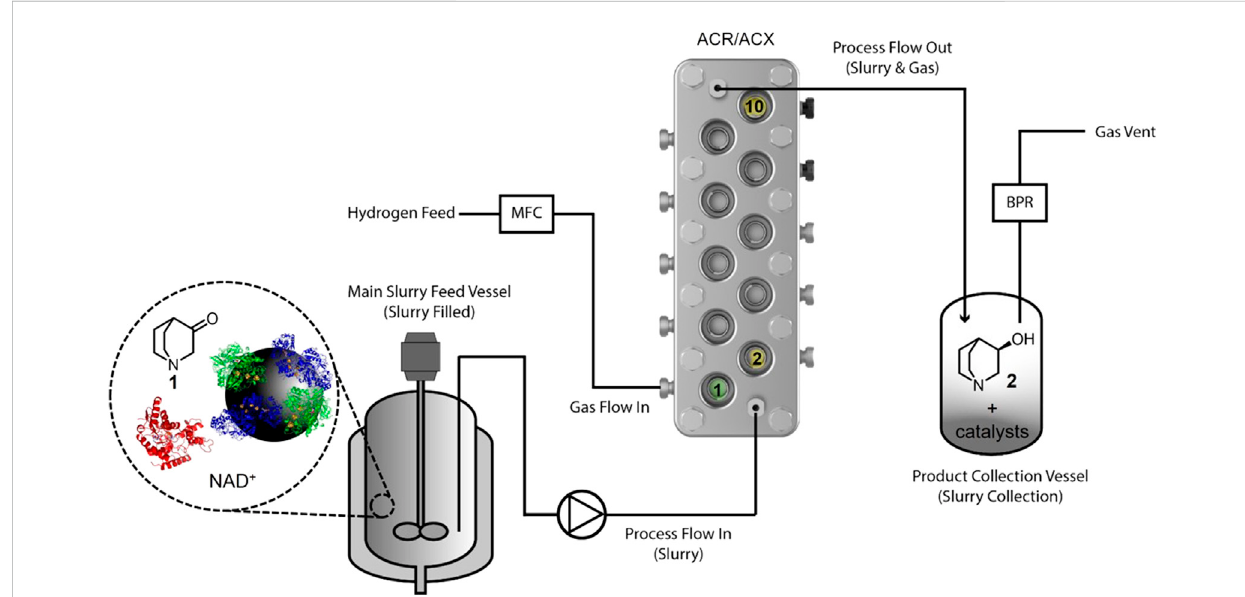
FIGURE 4 Continuousbiocatalytichydrogenationof3-quinuclidinone( 1 )usinganagitatedreactor(ACRorACX).Theslurryfeedwasstirredinajacketedvessel and pumped into the agitated reactor. Both the H 2 and the suspension were dosed into the fi rst cell “ 1 ” . The reactor temperature was monitored at cells 2 and